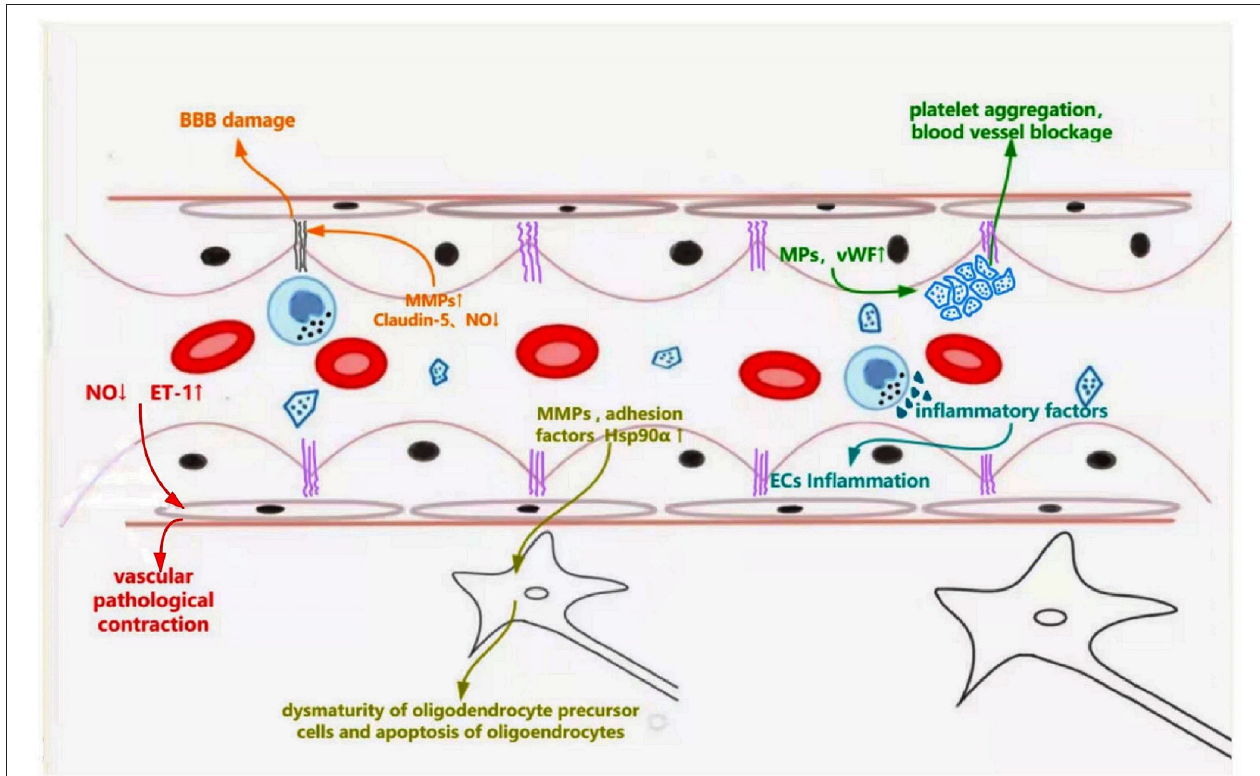
FIGURE 2 | Schematic representation of dysfunctional ECs linking to specific features of cerebral small vessel disease. Dysfunctional ECs induce abnormal secretion of NO and endothelin-1, which leads pathological vascular contraction. Increased secretion of MMPs and decreased production of claudin-5 destroy the tight connections, leading to blood-brain barrier leakage. Abnormally released MMPs, adhesion factors (ICAM-1, VCAM-1), and Hsp90 α result in dysmaturity of oligodendrocyte precursor cells and apoptosis of oligodendrocytes, which affects the myelination. Endothelial microparticles and vWF are released from the damaged ECs, causing platelet aggregation and inflammatory